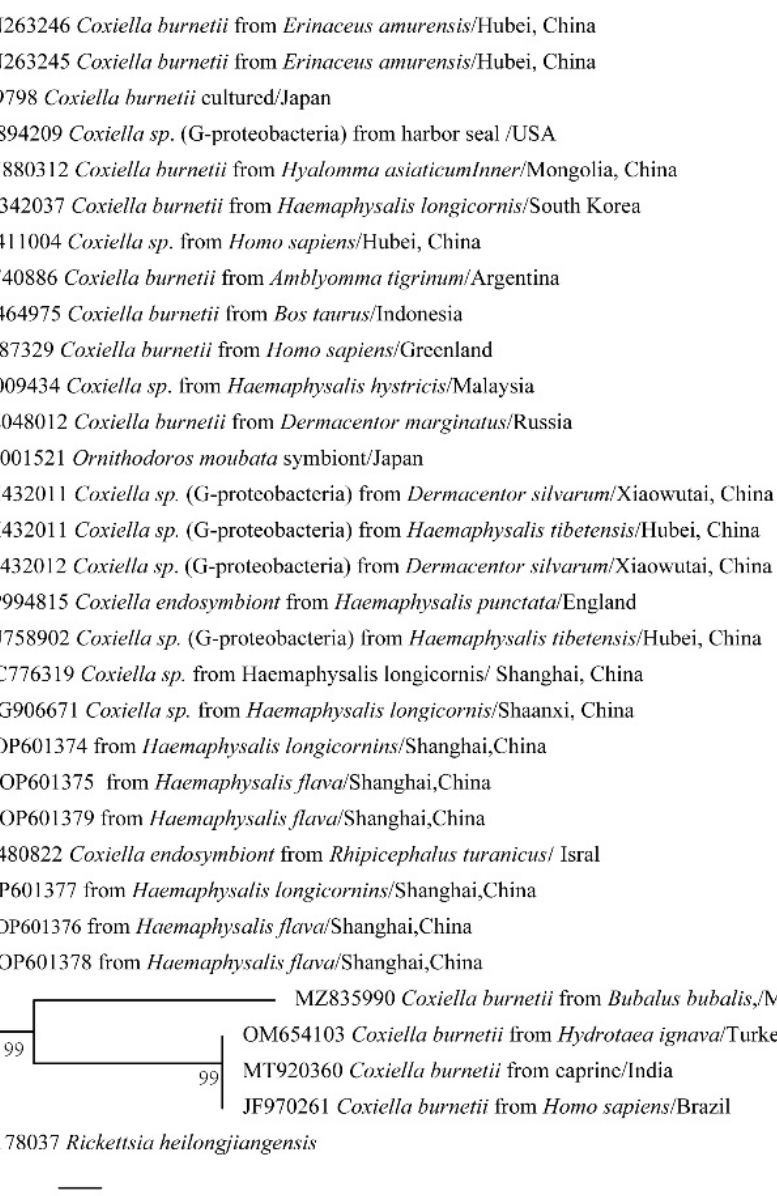
Figure 12. Phylogenetic tree of Ehrlichia spp. in ticks based on partial 16S rDNA gene sequence sim ‐ ilarity. The sequence from H. flava obtained in this study is indicated with a black triangle, and the